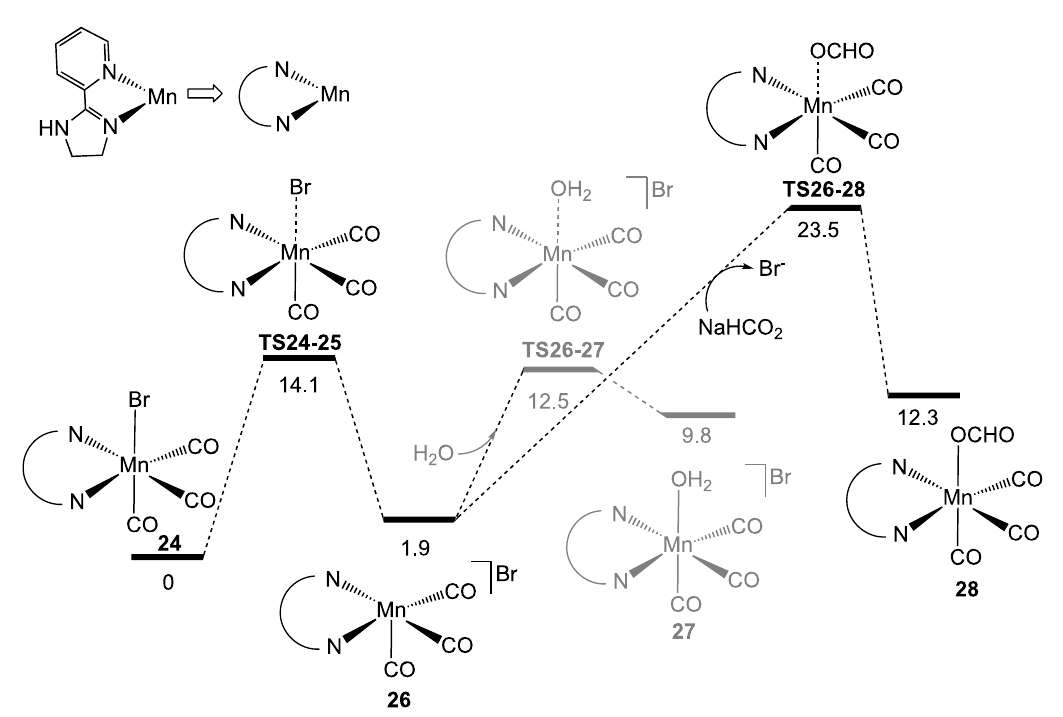
Scheme 11. Energy profile for the formation of the Mn-formate active species 28 from 24 .